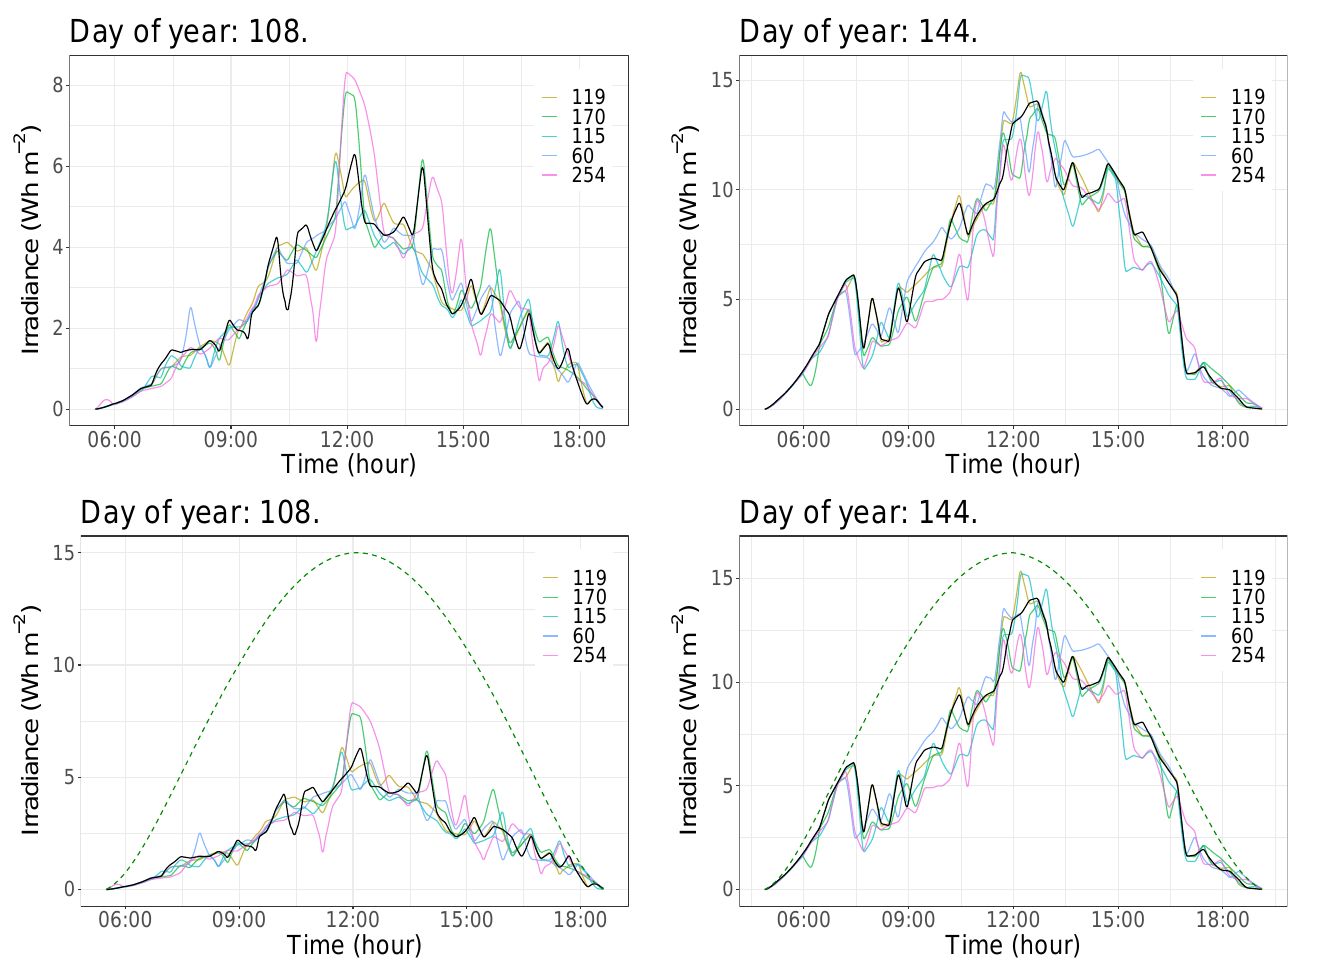
Figure 10. Example of irradiance data for two days: curves used for short-term forecasting purposes— clear sky GHI data included in dashed line. Curve in the forecasting point is marked in black